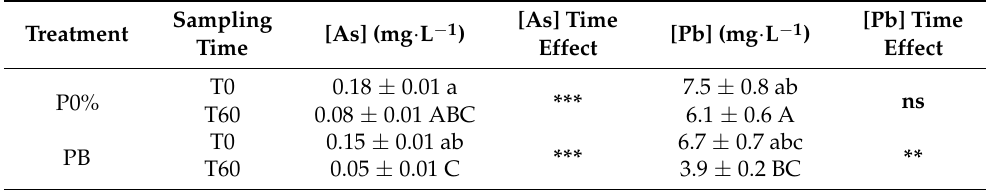
Table 4. Soil pore water (SPW) arsenic [As] and lead [Pb] concentration (mg · L − 1 ) determined in the eight studied treatments. SPWs were sampled at the beginning of the experiment (T0) and after 60 days of Salix triandra plant growth (T60). The “treatment effect” for each sampling time is represented by lowercase letters for T0 and capital letters for T60 ( p < 0.05) ( n = 5 ± SE). In detail, for each sampling time, different letters indicate a significant difference among the treatments. The letters “a” and “A” are used for the highest value found. Different treatments with at least one letter in common show no significant difference. Thus, different treatments not having any letter in common are significantly different from each other. “Time effect” for each parameter and treatment is shown by: * ( p < 0.05), ** ( p < 0.01), *** ( p < 0.001), ns (non-significant). In detail, the “time effect” concerns any differences found between the two sampling